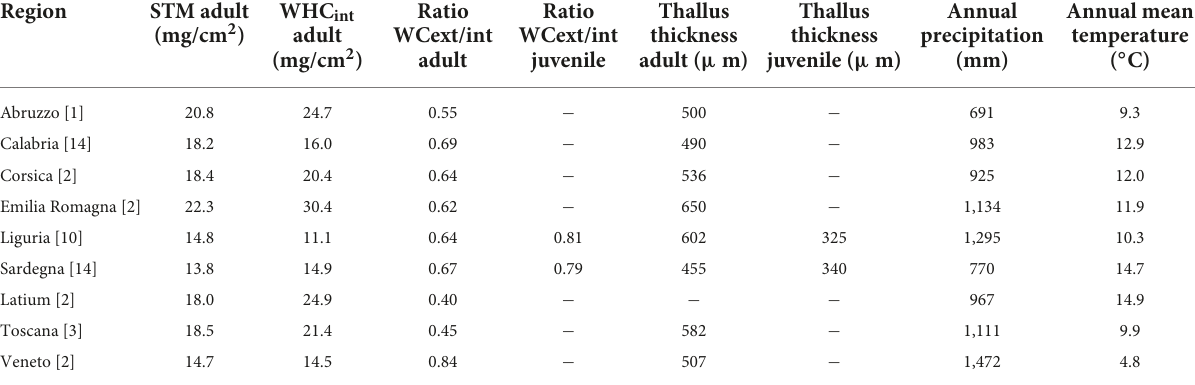
TABLE 1 Median of measured values for each region.